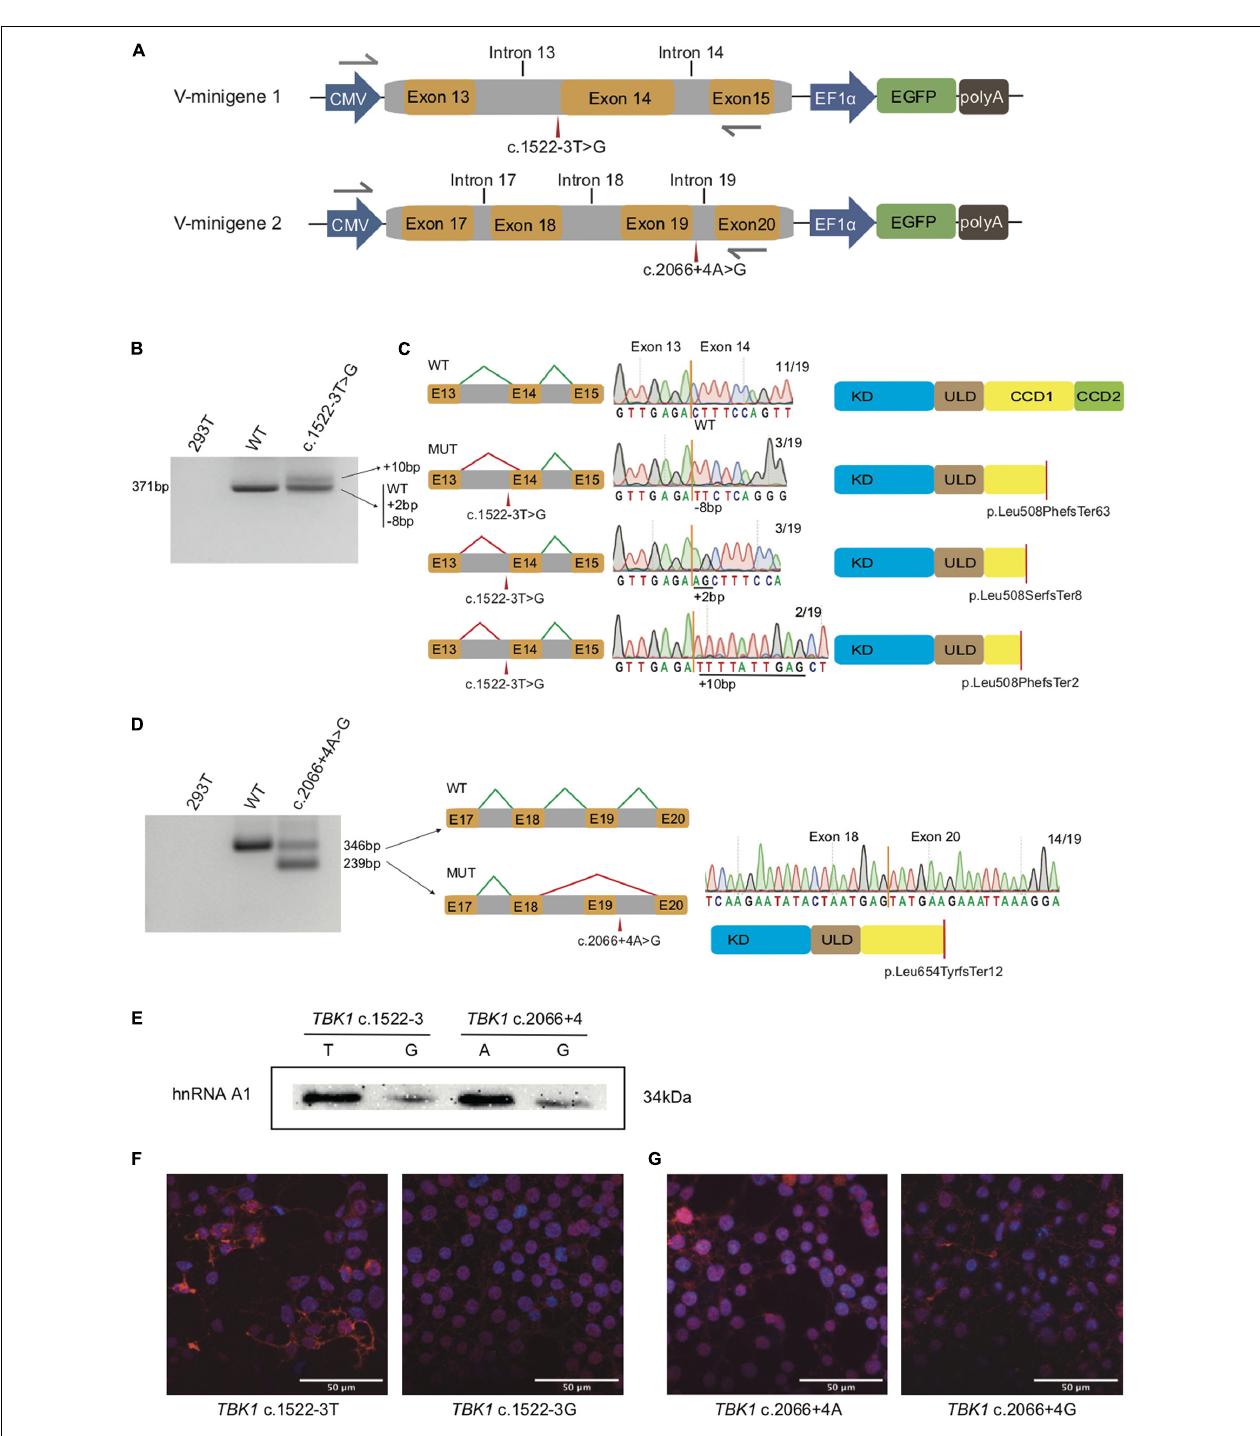
FIGURE 1 | Splicing modes verification and functional characterization of the two TBK1 intronic variants. (A) Construction of V-minigene 1 (bearing TBK1 c.1522-3T > G variant) and V-minigene 2 (bearing TBK1 c.2066 + 4A > G variant) plasmids. The minigene plasmids contain CMV promotor, consecutive genomic DNA, EF1 α promotor and EGFP sequences. Yellow boxes indicate exons, gray boxes indicate introns, gray arrows indicate primers. (B) Agarose gel electrophoresis of RT-PCR products, lane 1: cDNA from HEK293T cells (blank control), lane 2: cDNA from W-minigene 1 plasmid (wild type control, bearing TBK1 c.1522-3T), lane 3: cDNA from V-minigene 1 plasmid (bearing TBK1 c.1522-3T > G variant). (C) Left: schematics of normal splicing mode (WT) and aberrant splicing modes (MUT) of V-minigene 1 plasmid; yellow boxes indicate exons, gray boxes indicate introns, green lines show normal splicing modes, red lines show aberrant splicing modes, E13: exon 13, E14: exon 14, E15: exon 15. Middle: T-A clone results of RT-PCR products from V-minigene 1 plasmid. Right: Schematics of TBK1 protein